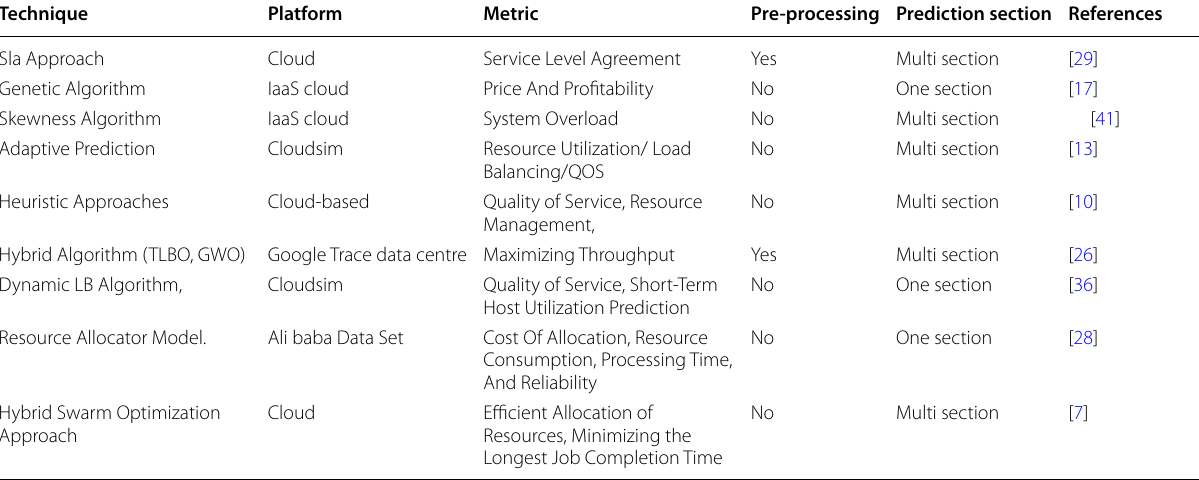
Table 1 Summary of related